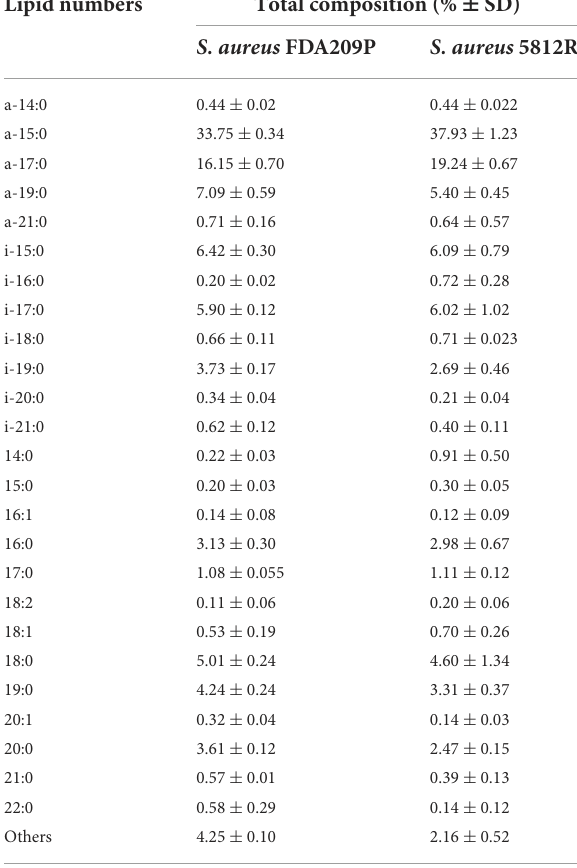
TABLE 3 The membrane fatty acid composition of S. aureus cells. Lipid